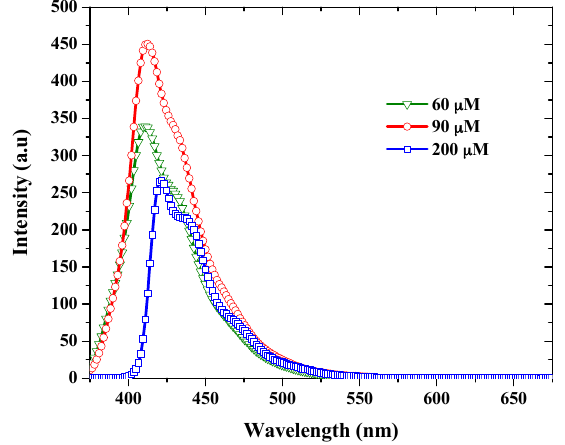
Figure 4. Fluorescence spectra of PFO-co-pX in THF for different concentrations.